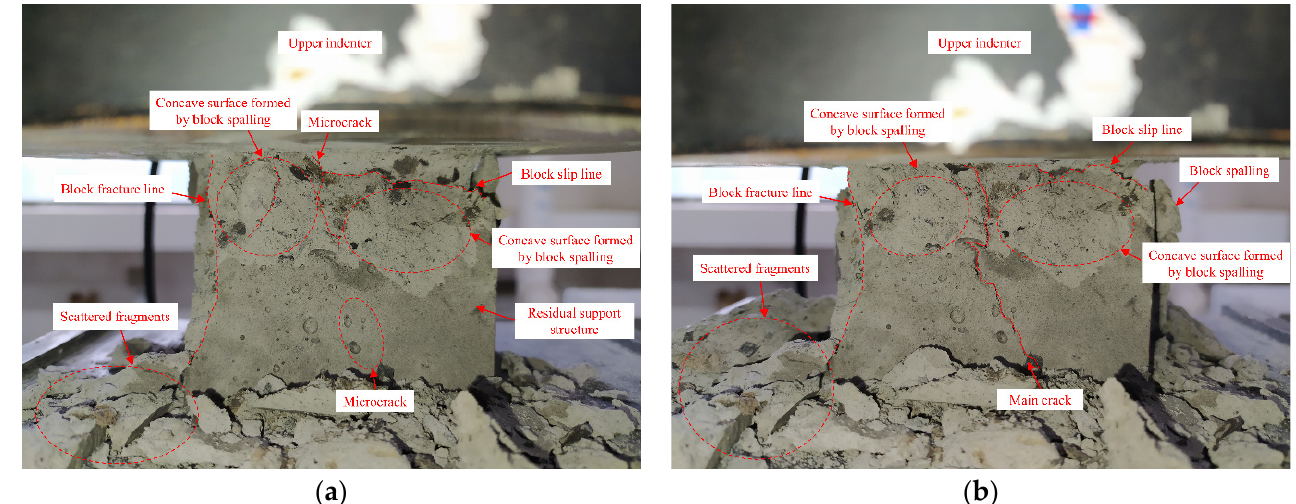
Figure 11. Failure morphology of specimens in experimental group D: ( a ) before the maximum rebound stress; ( b ) after the maximum rebound stress.